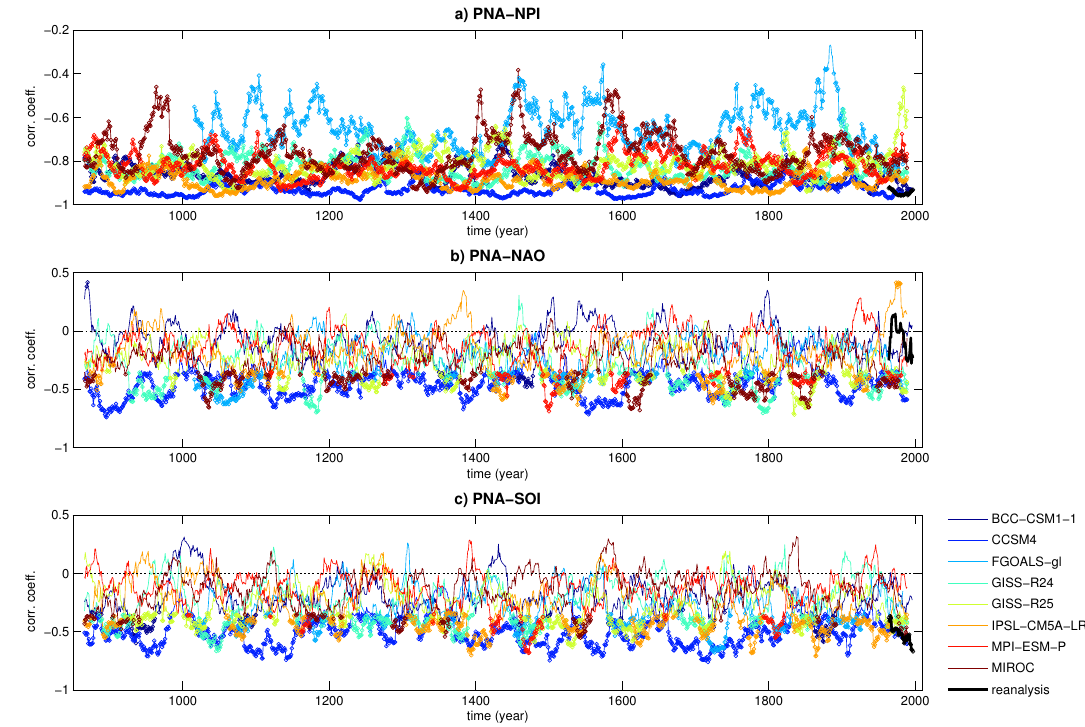
Figure 5. Running-window (31-year) correlations of the winter (DJF) PNA with winter NPI (a) , NAO (b) and SOI (c) indices for simulations (colored lines) and reanalysis (black thick lines) data. Dots mark when the correlation is statistically significant at 95% confidence accounting for